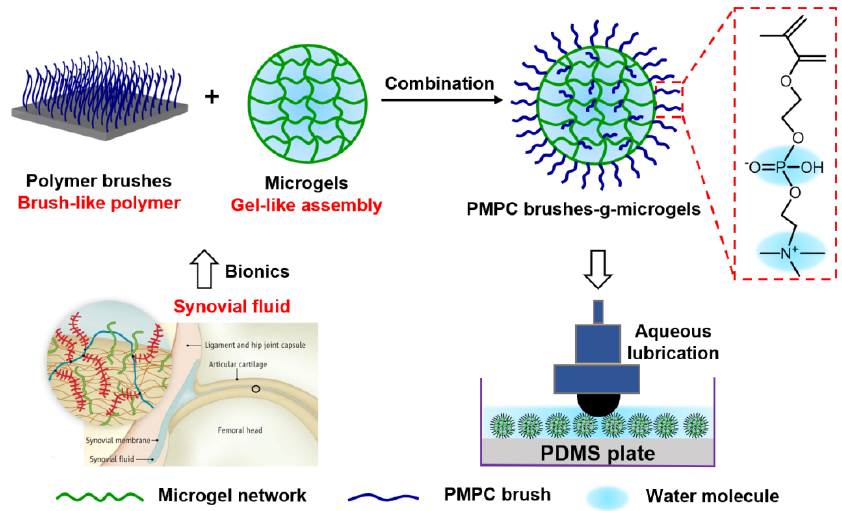
Fig. 1 Schematic diagram illustrating the bionics design of PMPC brushes-g-microgels by learning from the synovial fluid on the surface of articular cartilage. Reproduced with permission from Ref. [33], © American Association for the Advancement of Science